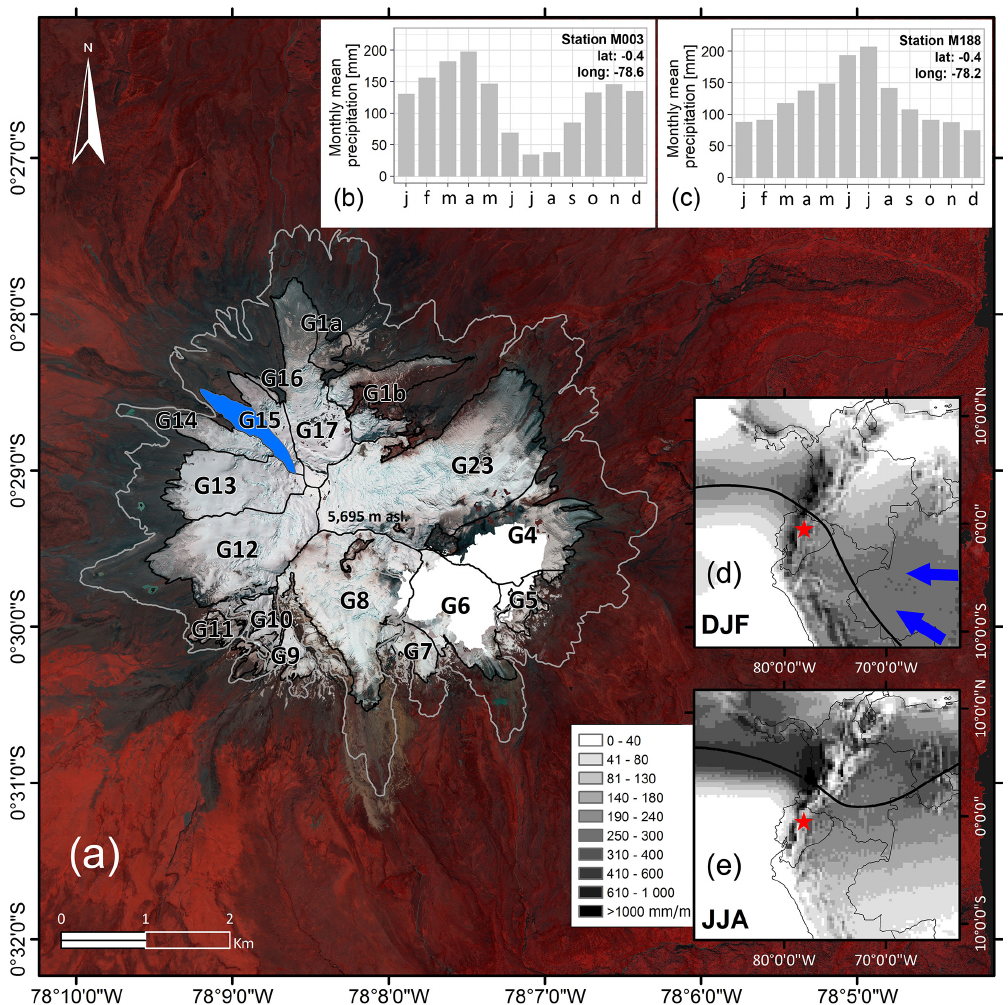
Figure 1. (a) The Antisana ice cap with its 17 glaciers. The blue polygon locates Glacier 15 where in situ observations have been available since 1995. The grey line represents the glacier boundaries in 1956, and the black lines represent the boundaries in 2016. Data are missing on the southeast side of the ice cap due to cloud cover (area shown in white). A false-colour (RGB 324) pan-sharpened composite of Pléiades 0.5m ortho-images used as the background shows the distribution of the vegetation in the surrounding glaciers (© CNES 2016, Distribution Airbus D&S). The bar charts in (b) and (c) show precipitation seasonality throughout the year in the 1950–2018 period measured at two weather stations, M003 (M188) located on the western (northern) side of the volcano (see Fig. 2). Panels (d) and (e) are the seasonal mean precipitation maps for December–February (DJF) and June–August (JJA) derived from ERA5 reanalysis data for the 1950–2018 period (shading scale). The solid black line shows the average position of the ITCZ estimated from the ERA5 precipitation rates and the South American Monsoon System (SAMS, blue arrows) during the austral summer (DJF). The red star locates Antisana volcano.